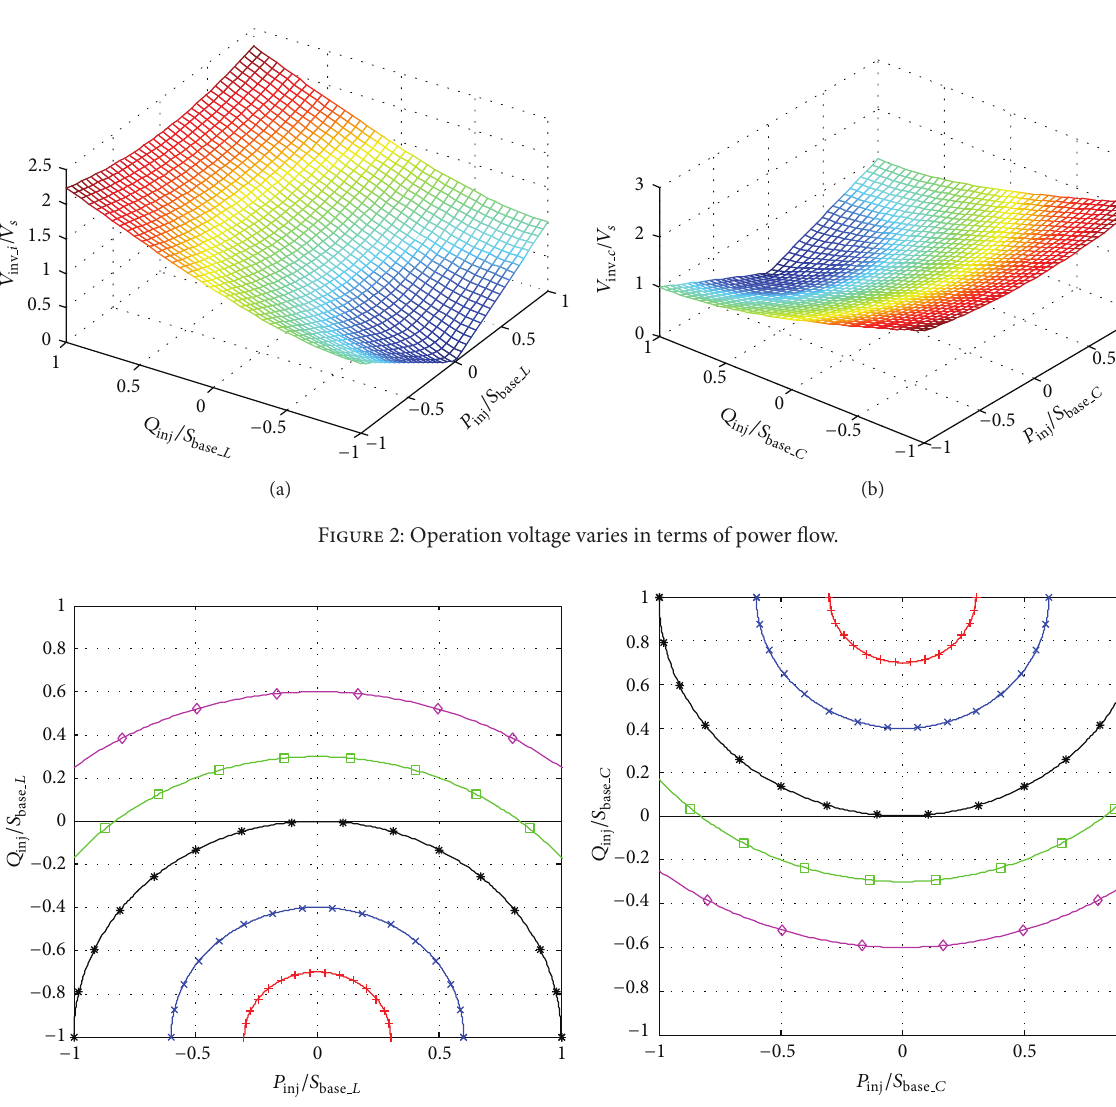
Figure 1: System configuration of the grid-connected VSI.